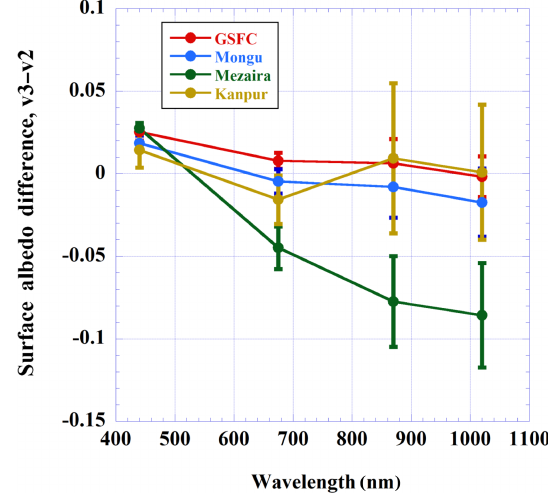
Figure 1. The V2 and V3 average differences and standard devia- tions in surface albedo calculated using BRDF parameters at four sites: Goddard Space Flight Center (GSFC, USA), Mezaira (UAE), Mongu (Zambia), and Kanpur